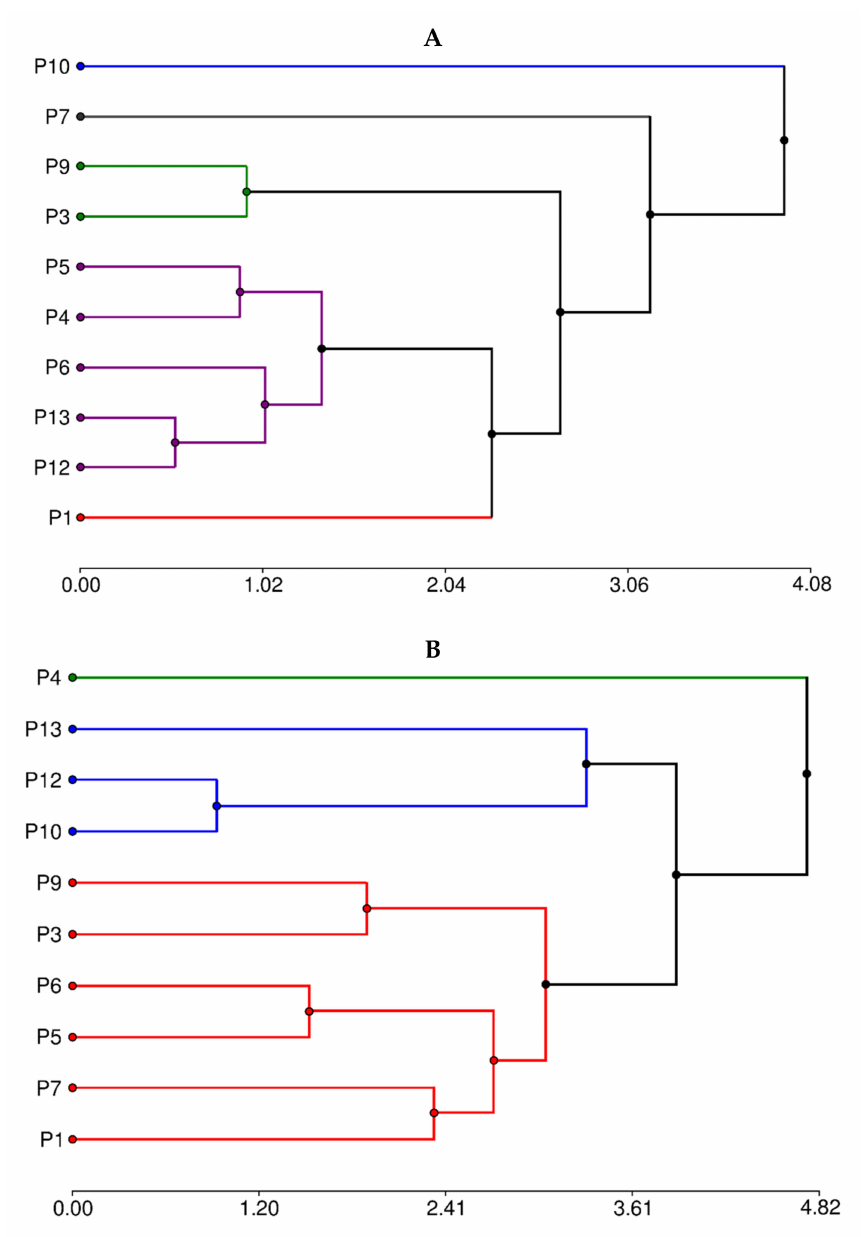
Figure 4. Hierarchical clusters analysis by ( A ) secondary metabolites composition and ( B ) proximal